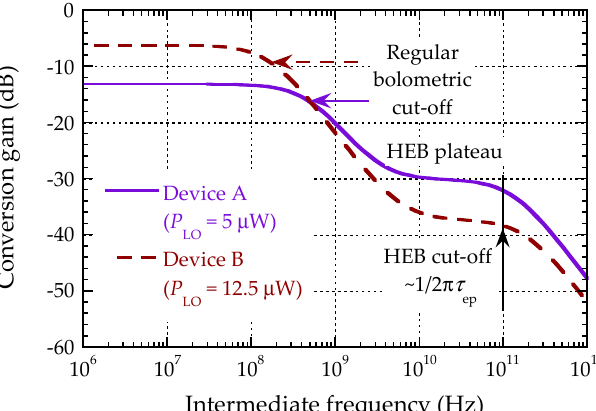
Figure 10. For devices A and B, conversion gain vs. f IF , at P LO values minimizing T DSB . Data for device A were available in the QS regime [25], whereas data at 2.5 THz were used for device B [45].